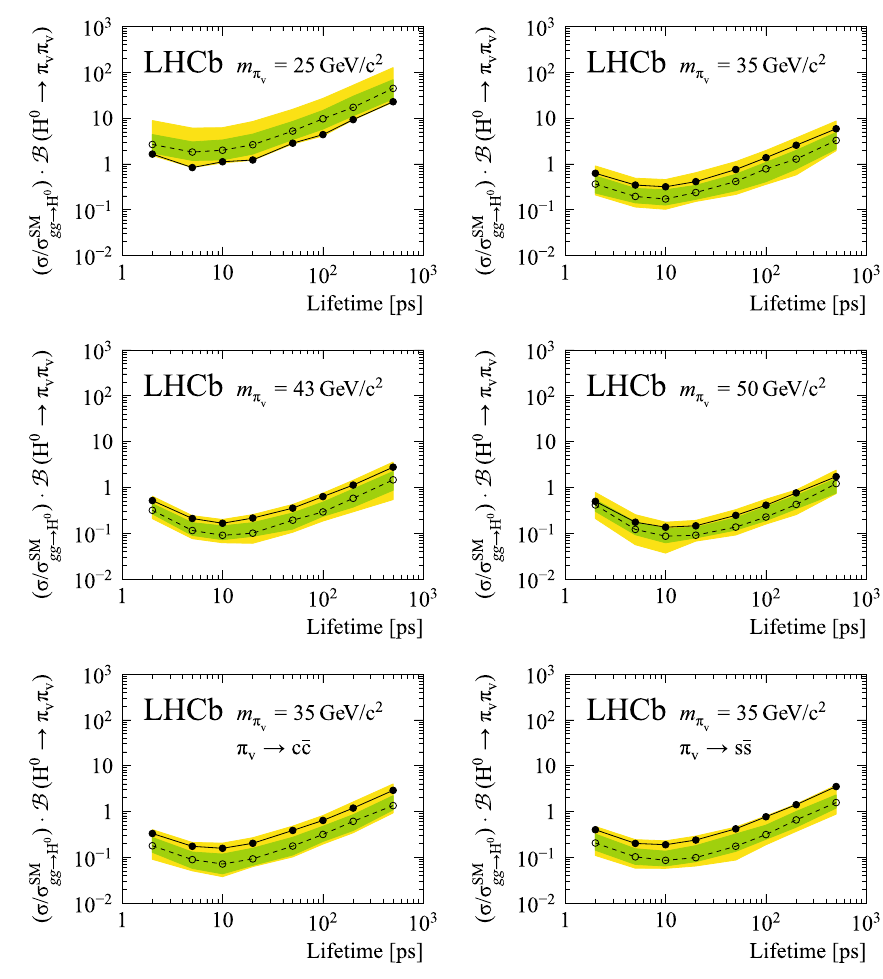
Fig. 3 Expected (open circles and dotted line) and observed (filled circles and solid line) upper limit versus lifetime for different π v masses and decay modes. The green (dark) and yellow (light) bands indicate the quantiles of the expected upper limit corresponding to ± 1 σ and ± 2 σ for a Gaussian distribution. The decay π v → b ¯ b is